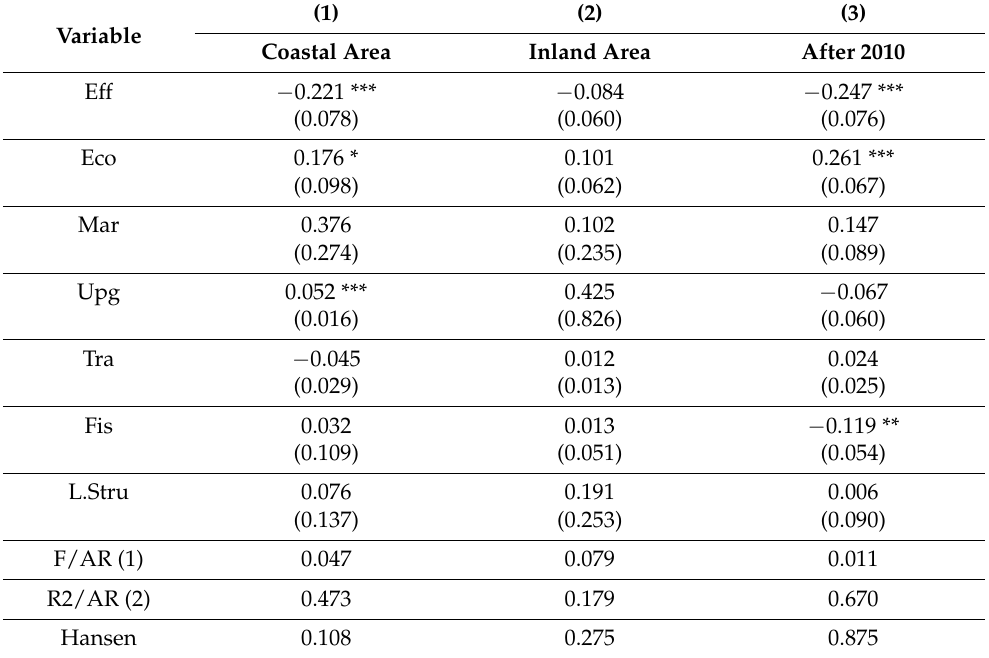
Table 3. Robustness and heterogeneity